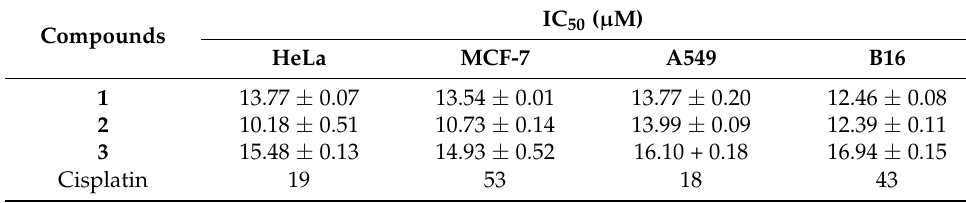
Table 4. The cytotoxic activity of the compounds after 72 h of treatment.